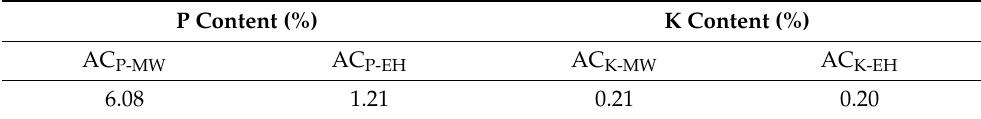
Table 2. Elemental content on activated carbon surface with respective activators.